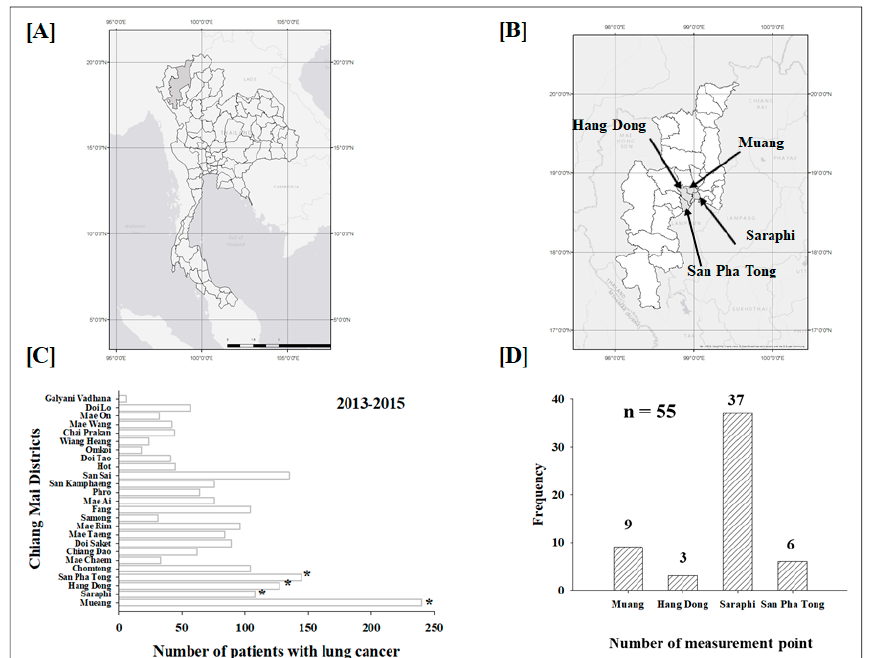
Figure 1. Geological map of the study area located in Upper Northern Thailand. ( A ) Geographical coordinates in Chiang Mai, Thailand. ( B ) Map of the study area. ( C ) Incidence of new lung cancer cases in the total of 25 districts of Chiang Mai from the years 2013 to 2015. ( D ) Frequency distribution of sampling sites in the study area.